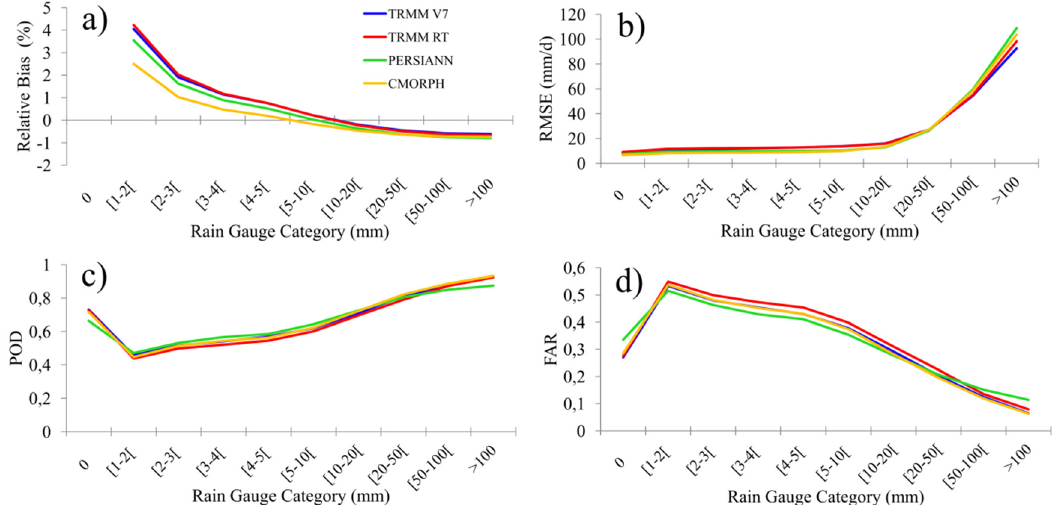
Figure 4. Statistical comparison between in situ rain gauges and satellite products for different classes of daily intensities: 0-1 mm, 1-2 mm, 2-3 mm, 3-4 mm, 4-5 mm, 5-10 mm, 10-20 mm, 20-50 mm, 50-100 mm and >100 mm. Statistical criteria: ( a ) relative bias in %, ( b ) RMSE in mm/d, ( c ) POD and ( d ) FAR.